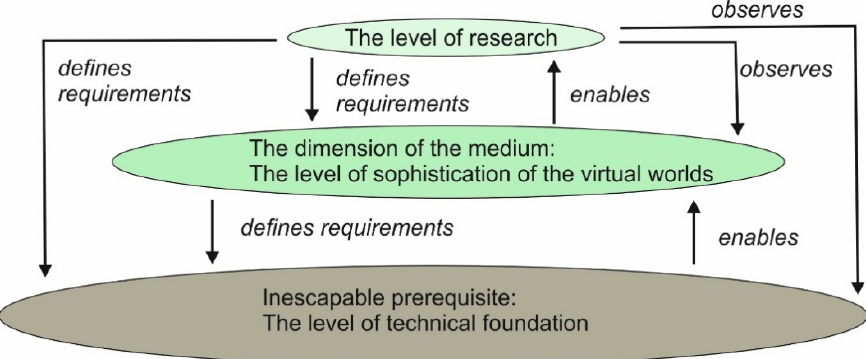
Figure 5. The different levels of VR research (own representation).